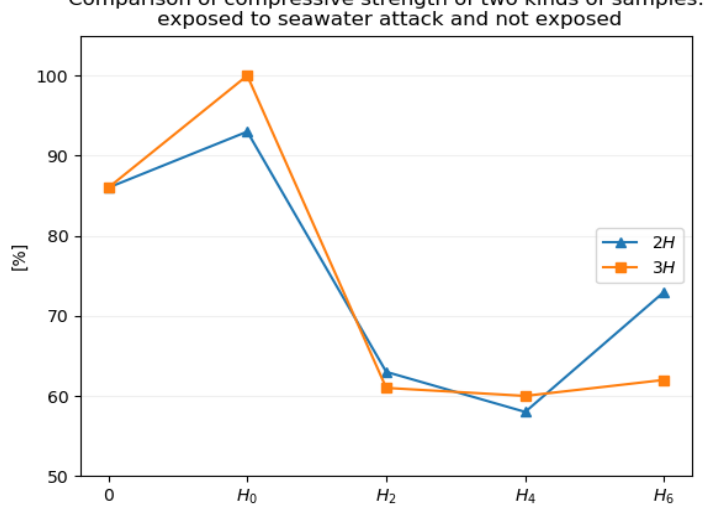
Figure 8. The changes of the compressive strength of the composite samples with ODFA and lime in comparison to the samples without lime subjected to the influence of seawater solution for 120 days.